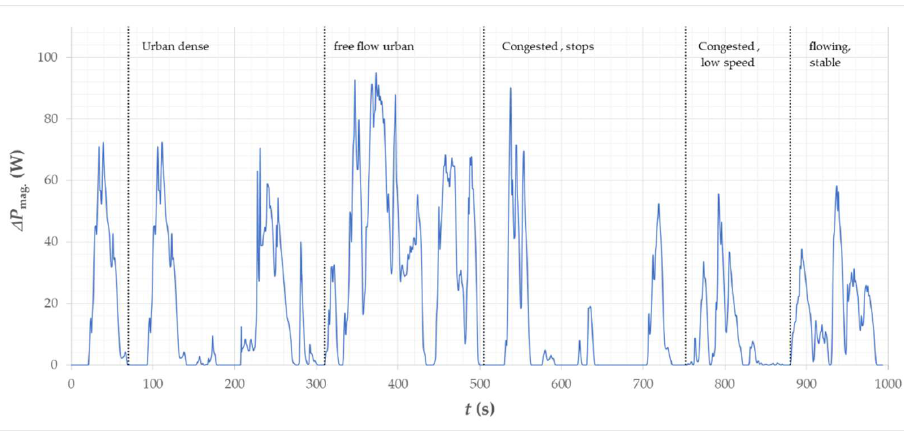
Figure 19. The calculated waveform of magnets loss in the motor for the Artemis Urban cycle .